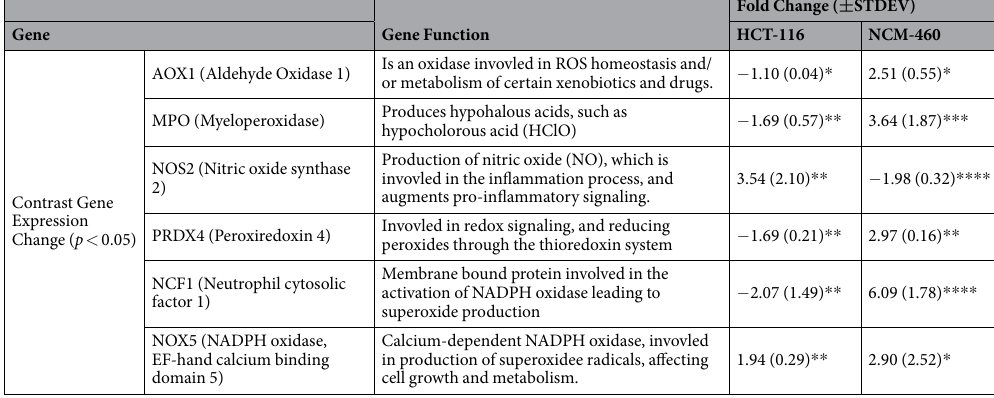
Table 2. Summary of the Relative-Fold Change in Gene Expression Utilizing RT 2 PCR. Statistical analysis was performed using One-Way ANOVA to relative-fold change of the control (1). * p < 0.05 vs control; ** p < 0.01 vs control; *** p < 0.001 vs control; **** p < 0.0001 vs control. n.s. = not significant, p > 0.05 vs control. N/A = not applicable due to no amplification detected. Gene function was obtained searching the UniProt or NCBI Gene